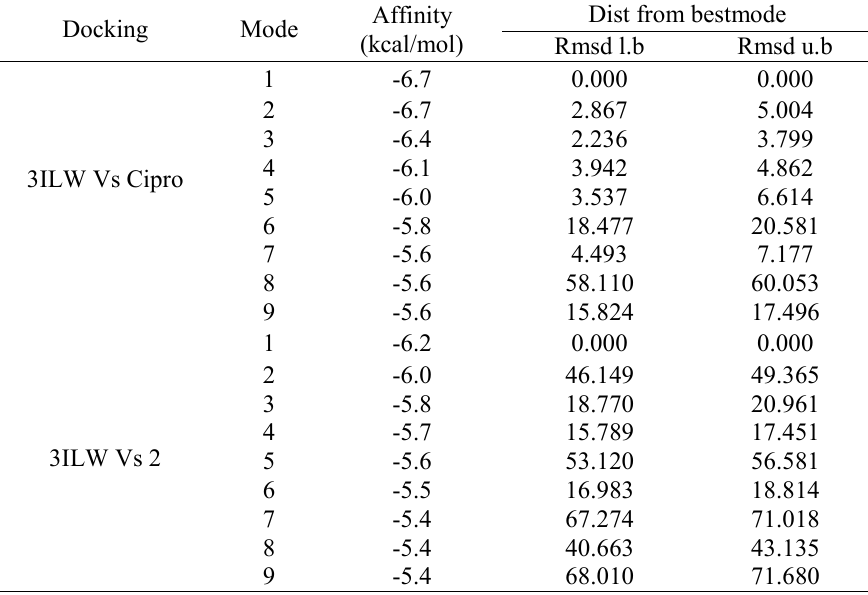
Table 2. Antibacterial activity of synthesized compounds.